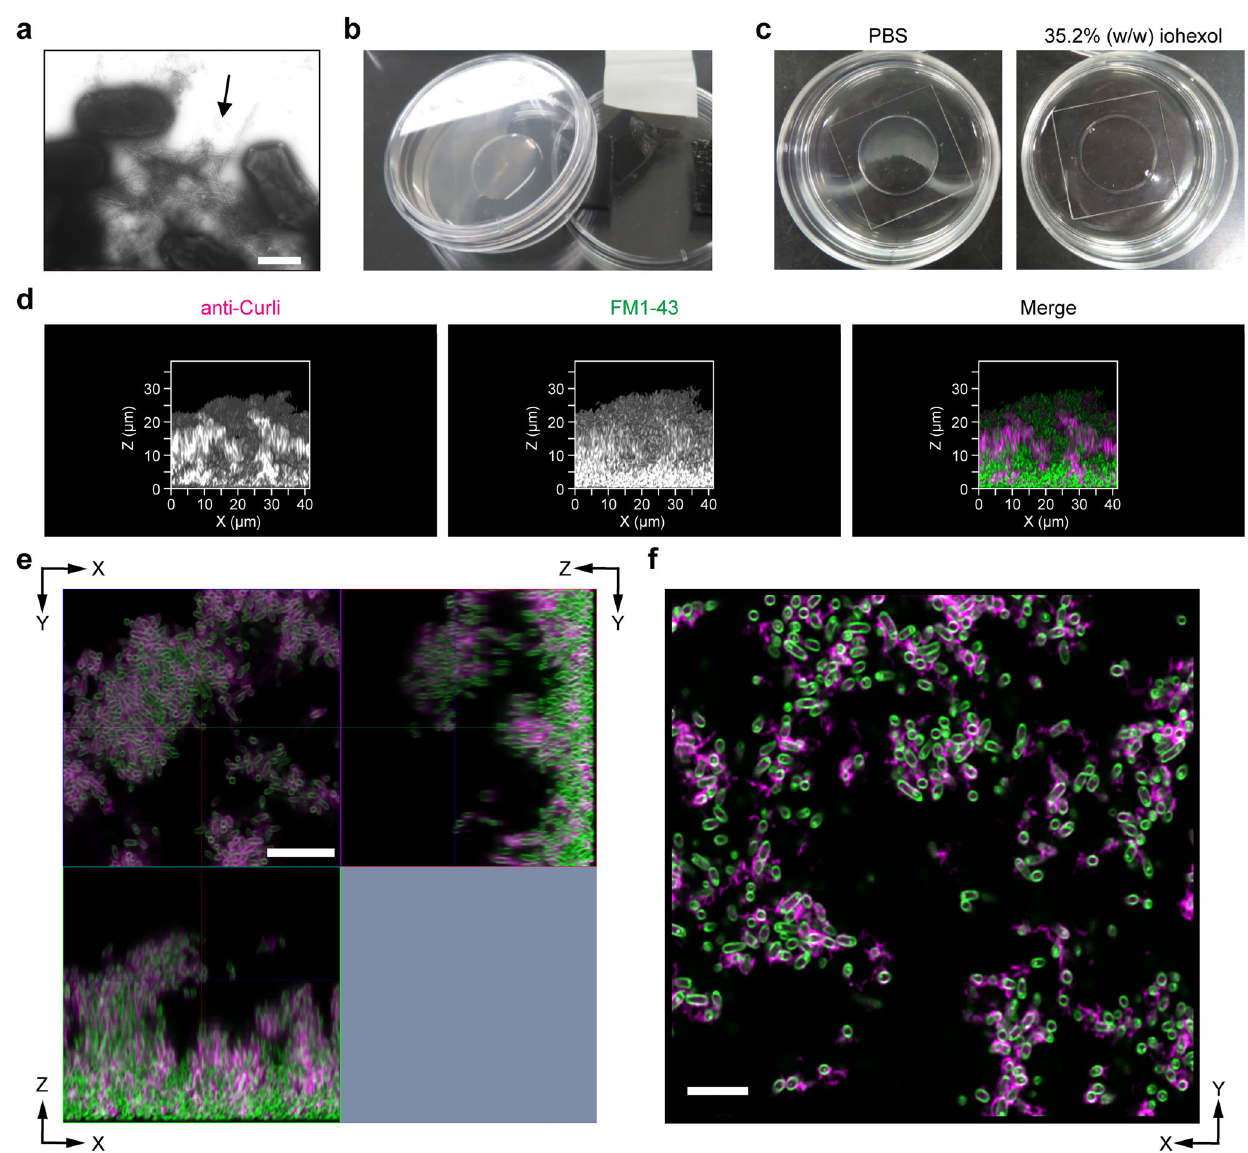
Fig. 6 Application of the iCBio fi lm method to Gram-negative bacterial bio fi lm. a A typical transmission electron microscopy image of E. coli BW25113 grown on YESCA agar plates. The image shows bacterial cells surrounded by Curli amyloid fi bers (black arrow). b Image of slanted YESCA liquid culture to form E. coli bio fi lm at the air-liquid interface. c E. coli bio fi lms soaked in PBS or 35.2% (w/w) iohexol. d Typical side views of E. coli bio fi lms stained with anti- Curli rabbit IgG and Alexa 647-conjugated anti-rabbit IgG (Curli, magenta) and FM1-43 (cells, green). The bio fi lm was soaked in 35.2% (w/w) iohexol solution and observed using an LSM800 microscope with ×63 and ×100 objective lenses and an Airyscan super-resolution unit. e Orthogonal images. f A typical X-Y section for the selected z-stack position. Scale bars are 500 nm in a , 10 μ m in e , and 5 μ m in f